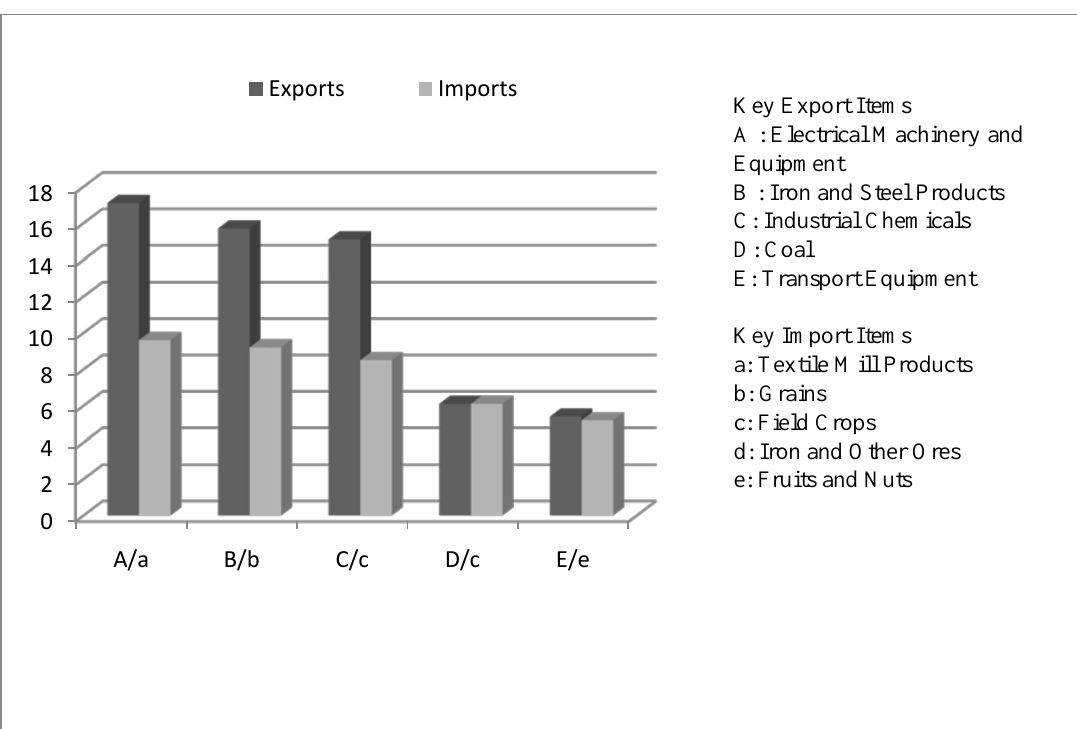
Figure 1. Germany's International Trade (Annual Average in %, 1934-37)